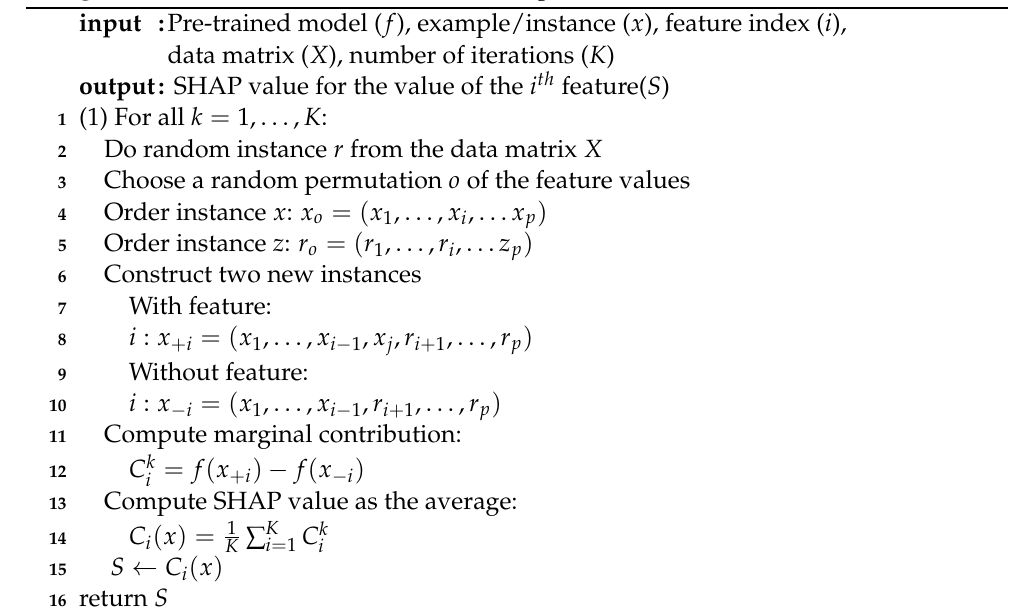
Algorithm 3: SHAP value estimation for single feature value